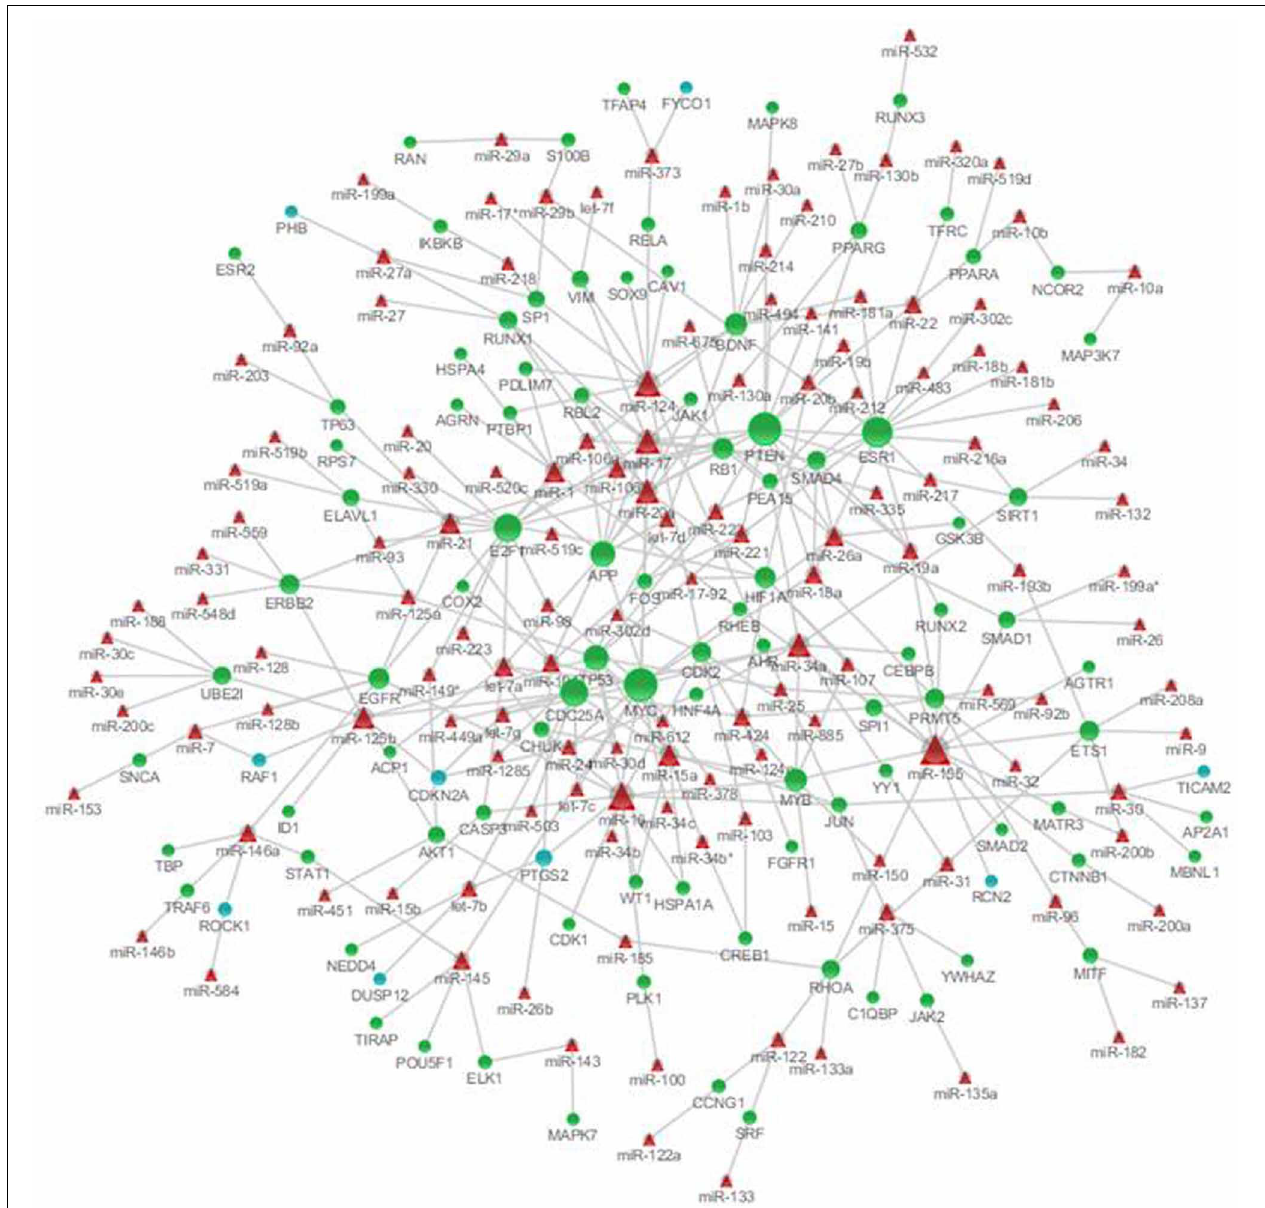
FIGURE 8 | MicroRNAs targeting on nodes of genetic sub-network in the brain of SAMP8 mice. In this miRNA-gene bipartite graph network, round nodes represent genes in the PPI, co-expression, and MetaCore sub-network in the brain of SAMP8, blue round